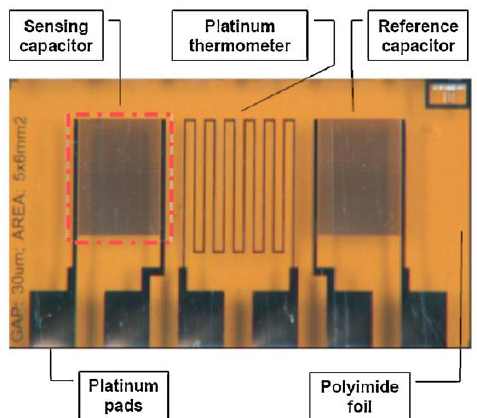
Figure 2. The sensor platform substrate with Pt thermometer, electrodes and connection pads. The interdigital electrode structures realize two plane capacitive transducers, a sensing one ( left ) and a reference one ( right ). The area reserved for the polymer sensing layer is surrounded by a dot line frame. Reprinted with permission from [13]. Copyright 2009: